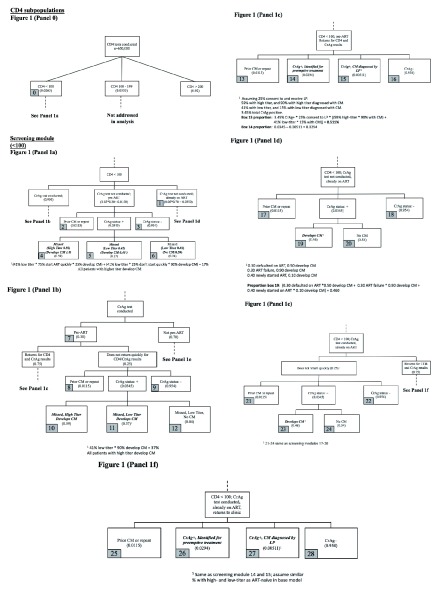
Flowcharts of screening module.Panel
0 describes the proportion of CD4 tests with a CD4 <100 cells/µL (target population for CrAg screening per national Botswana guidelines). (
a) Outcomes for pre-ART, CrAg-positive patients eligible for screening but in whom screening is not conducted. (
b) Outcomes for pre-ART patients who screen CrAg-positive but do no return for urgent follow-up. (
c) Outcomes for pre-ART patients who screen CrAg-positive and return for urgent follow-up. (
d) Outcomes for ART-experienced, CrAg-positive patients eligible for screening but in whom screening is not conducted. (
e) Outcomes for ART-experienced patients who screen CrAg-positive but do not return for urgent follow-up. (
f) Outcomes for ART-experienced patients who screen CrAg-positive and return for urgent follow-up.